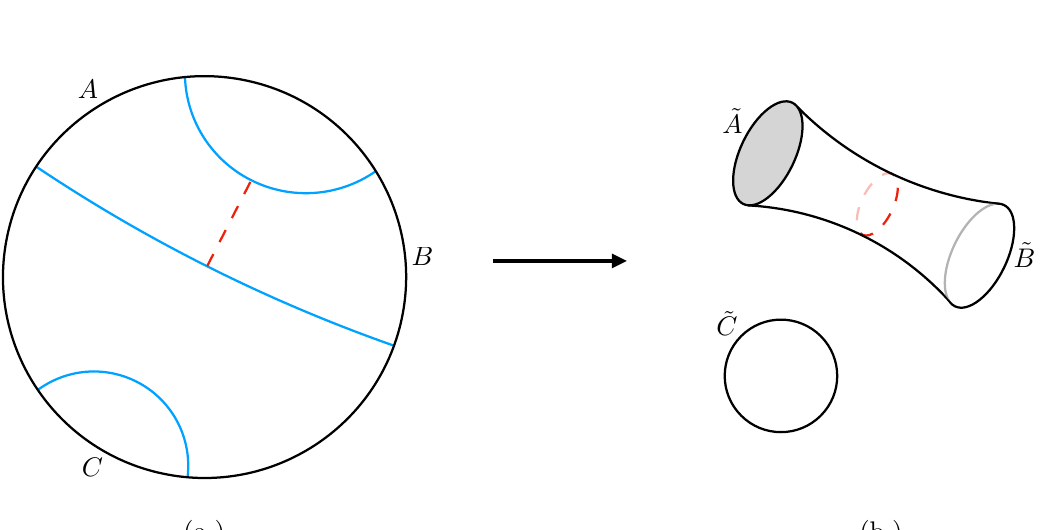
Figure 10 . Another phase, in which the entanglement wedge of ABC is a disjoint union of the entanglement wedge of AB and that of C . The entanglement wedge for AB is mapped onto a two-sided wormhole and its entanglement wedge cross section (red dashed line) is mapped to the Ryu-Takayanagi surface associated with a complete boundary, while C is mapped to a trivial hyperbolic geometry.